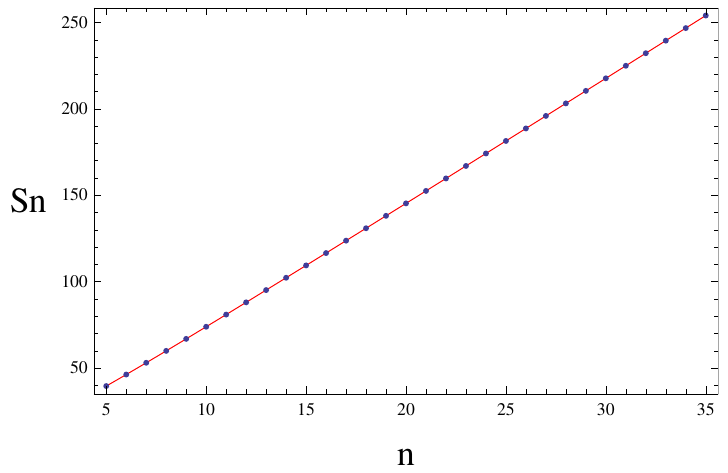
Figure 19 . The entanglement entropy of gauge (cid:12)eld with (cid:25)